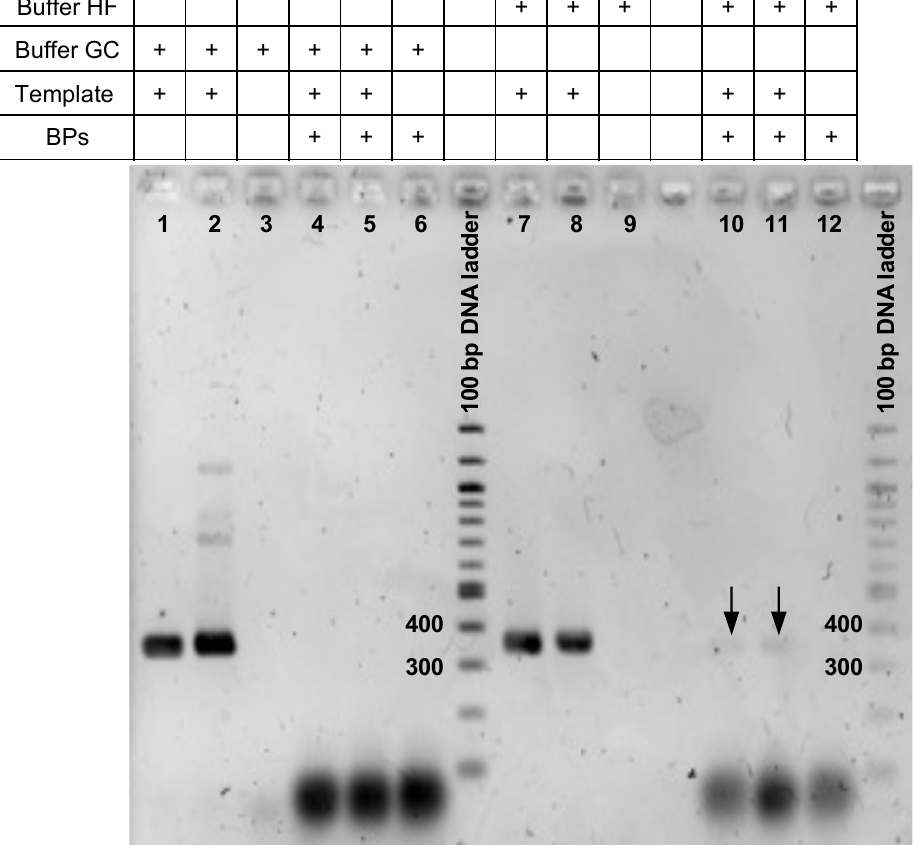
Figure 1. Control epicPCR amplifications targeting SXT/R391 ICEs performed on beads carrying E. coli MG1656::SXT MO10 as template. Each experiment was done in duplicates with a no-template DNA control, using either the Phusion DNA Polymerase GC or HF buffers. In the nested-PCR step, the use of blocking primers (BPs) has been done as depicted in Spencer et al. (2016), and usually performed so far. All these conditions are summarized in the table upper the gel. The expected size of the desired DNA fragment is 367 bp. Black arrows indicate epicPCR products obtained after performing fusion and nested PCRs using HF but not GC buffer.